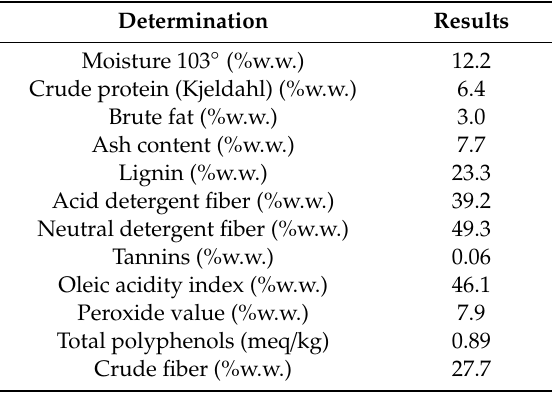
Table 3. Fermented defatted alperujo (FDA)